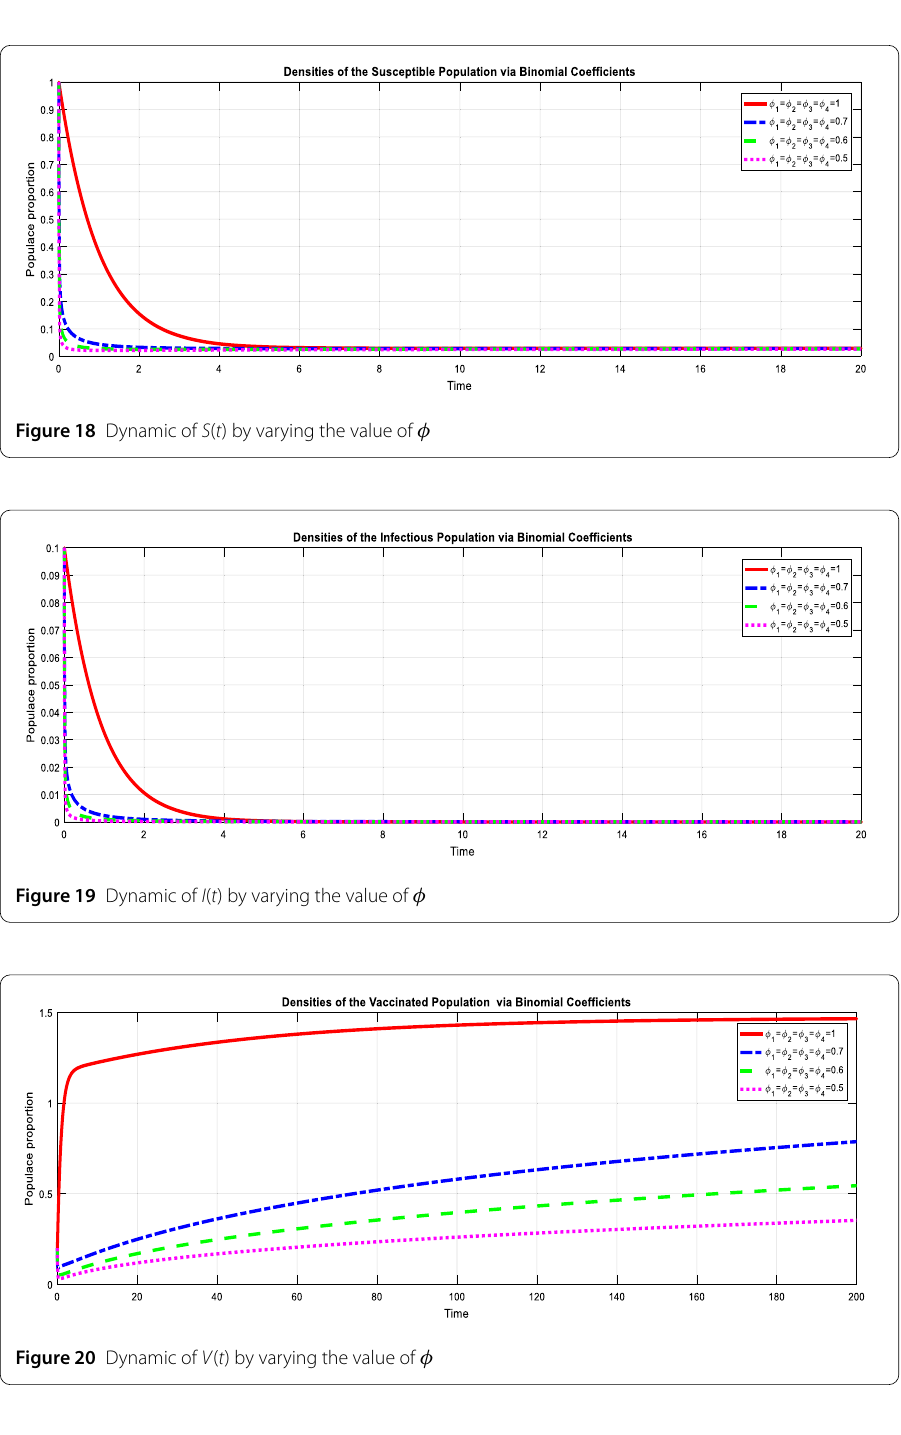
So by using the generalized Euler method for system (17), we have the subsequent dis- cretized